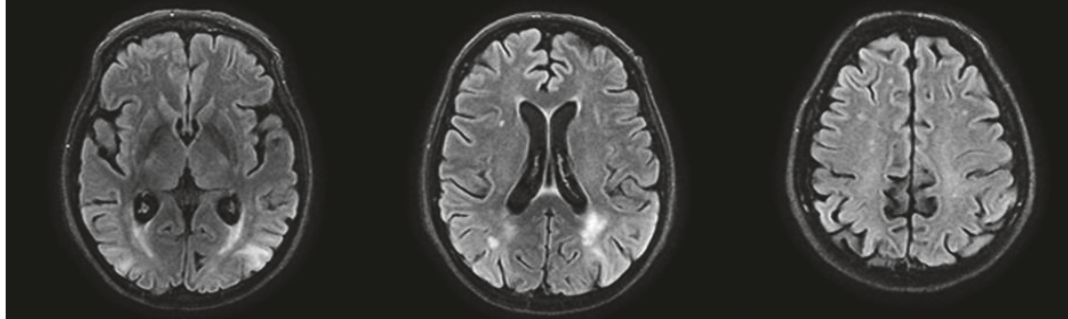
Figure 4: Case No. 2. One-month follow-up brain MR. Flair sequences showing alterations of signal in the white matter and cortex of the left temporal and occipital lobes and, to a lesser extent, of the right occipital